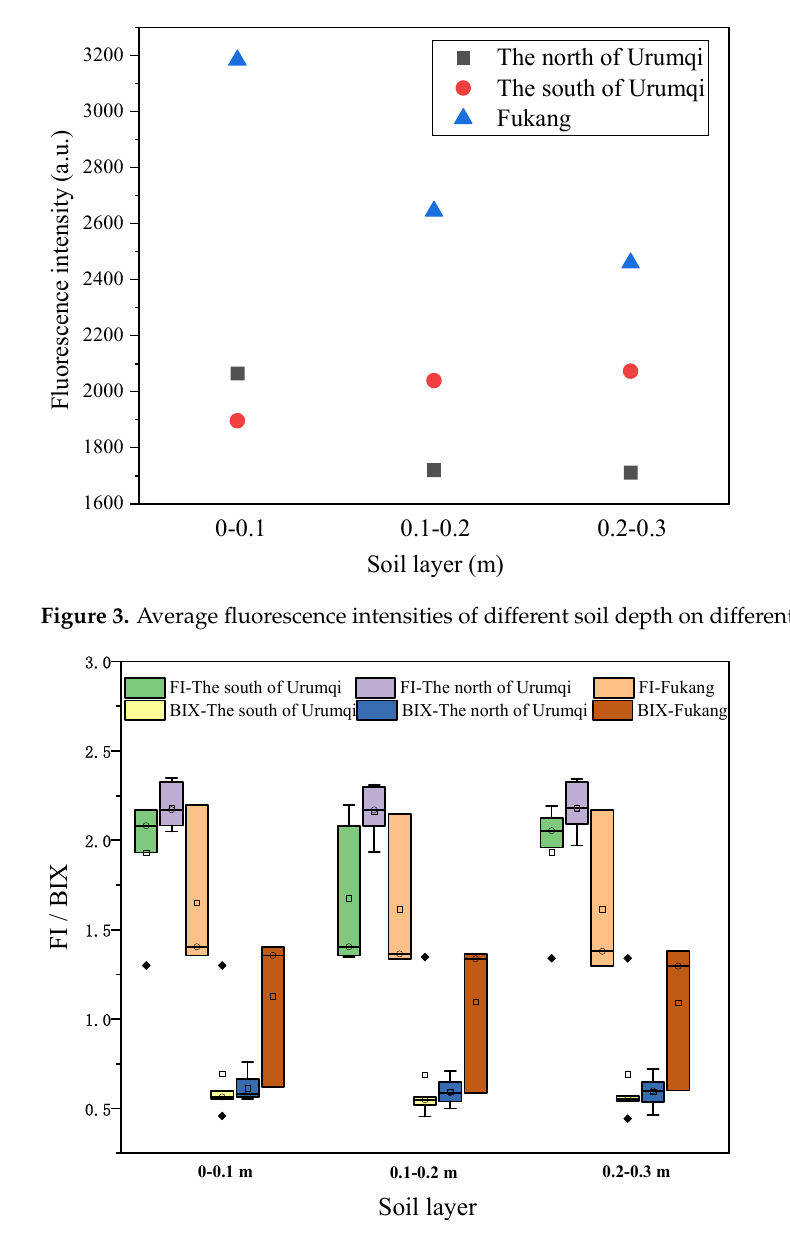
Figure 4. FI (fluorescence index) and BIX (autochthonous index) of soil DOM on different districts. The content of hydrophobic components of DOM molecules is generally defined as SUVA 260 [46]. Higher SUVA 260 indicates greater hydrophobic components. Table 2 shows that the range of SUVA 260 of all samples in the study area ranged from 0.92 to 3.12. The overall variation of hydrophobicity is consistent with the aromaticity of each